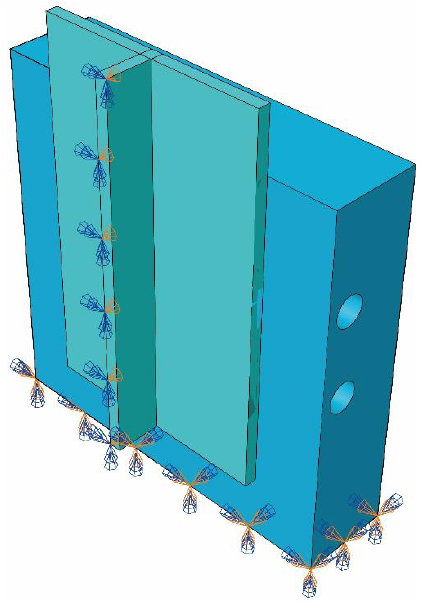
Figure 16. Boundary conditions of the model.